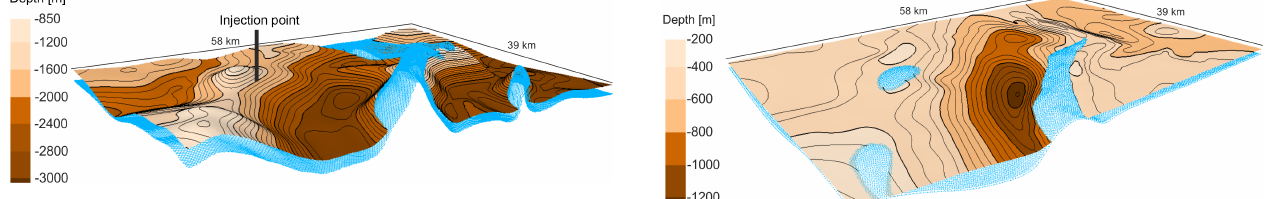
Figure 3. Depth contour map of the top of the Solling injection horizon. The top of the Zechstein salt is displayed with the blue mesh, with the salt wall piercing through the injection horizon. The injection point at the flank of the anticlinal structure in about 1600m depth is projected on top of the Solling storage horizon. Vertical exaggeration is 2 : 1.